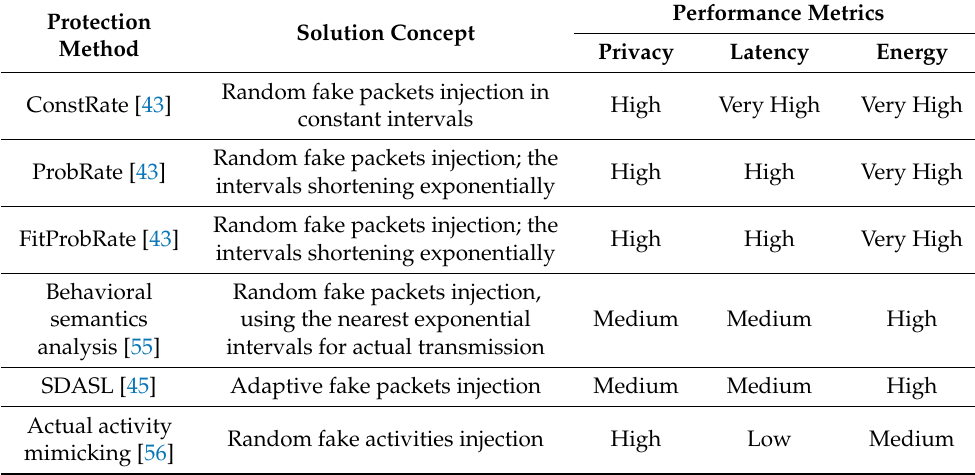
Table 1. Comparison of the existing solutions against FATS